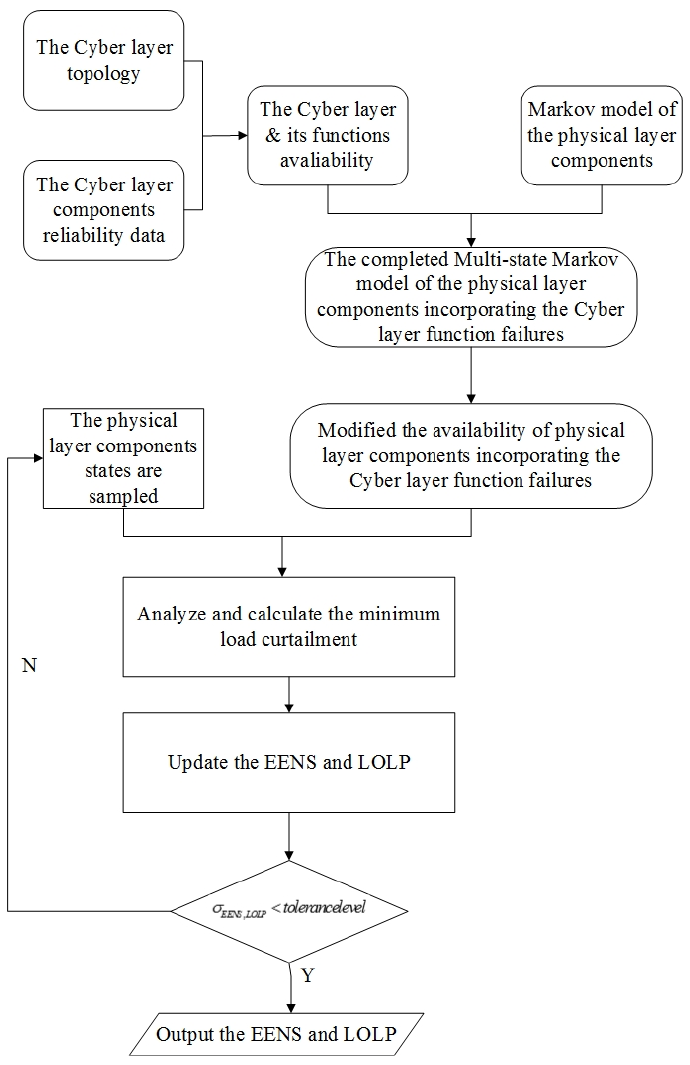
Figure 10. The overall procedure of the proposed reliability evaluation